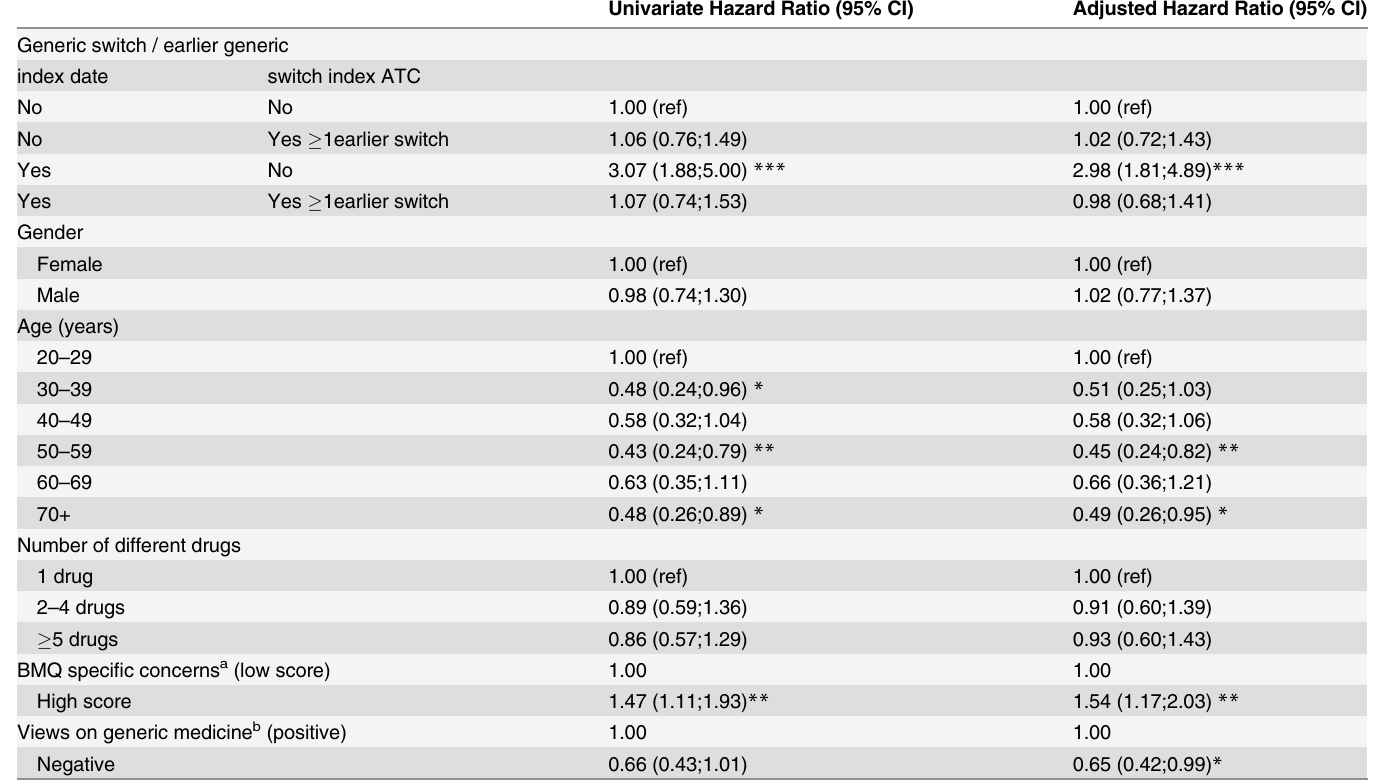
Table 2. Hazard ratio of non-persistence.